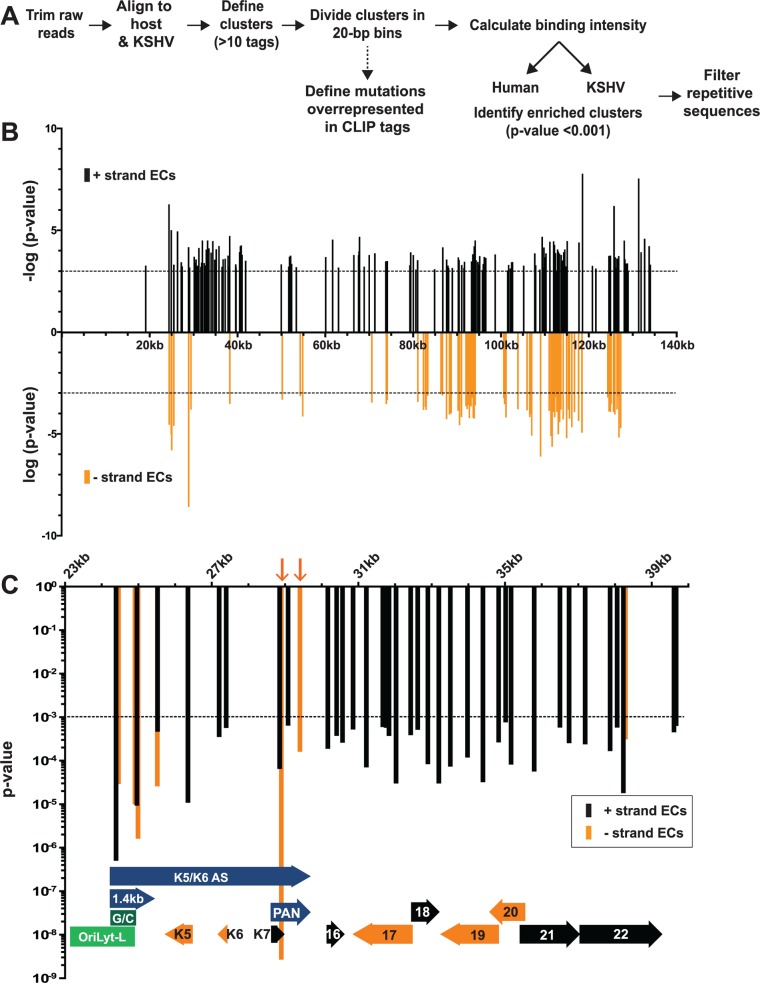
Identification of enriched clusters mapping to the KSHV genome.(A) Outline of the bioinformatic pipeline used to identify enriched clusters. (B) Genomic location of KSHV enriched clusters. The x-axis represents position on the KSHV genome (U75698) and the midpoint of each cluster was used as the x-coordinate. KSHV enriched clusters ranged from 19–3679 nt; the mean enriched cluster length was 176 nt and the median was 79 nt. A statistical cutoff of 0.001 was used to define enriched clusters (dashed lines). For display, the RNA fragments mapping to the KSHV plus strand were assigned -log10(p-values) (black) while the minus strand clusters are displayed as log10(p-values) (orange). (C) Detailed examination of the enriched clusters from KSHV genome position 23kb-40kb. The plus and minus strands are in black and orange as in (B) but both are displayed as p-value. For the genome annotations shown at the bottom of the graph, plus strand ORFs are black arrows, minus strand ORFs are orange arrows, oriLyt-L elements are in green, and RNAs with potential noncoding functions are purple. Orange arrows point to enriched clusters on PAN RNA minus strand.